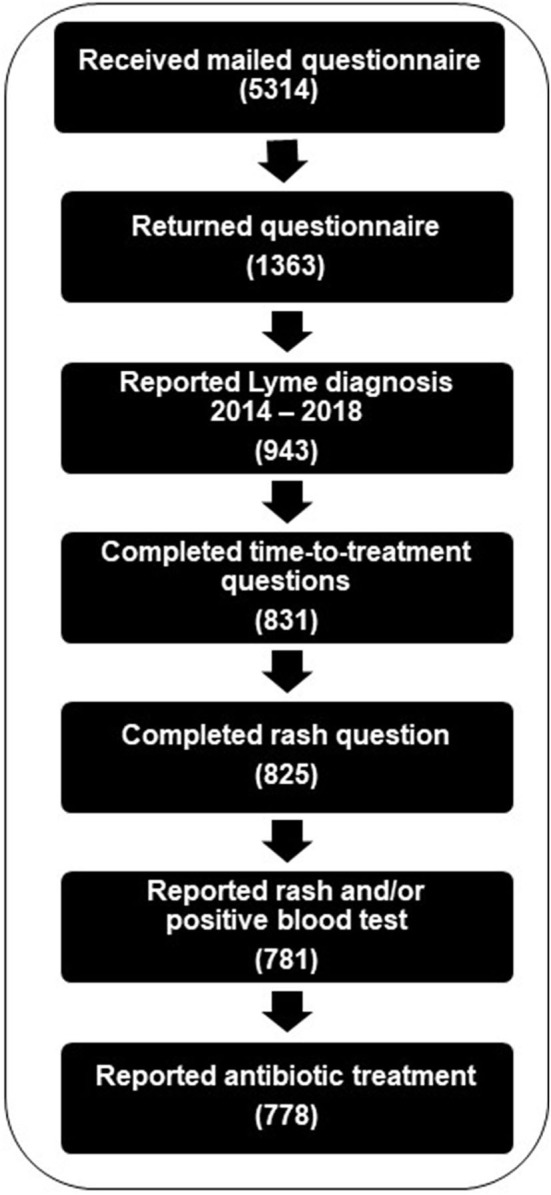
Creation of analytic dataset of respondents to the Lyme disease time-to-treatment questionnaire, with inclusion based on responses to questionnaire items regarding date of Lyme disease diagnosis, completion of time-to-treatment and rash questions with plausible response, report of rash and/or blood test, and report of antibiotic treatment.